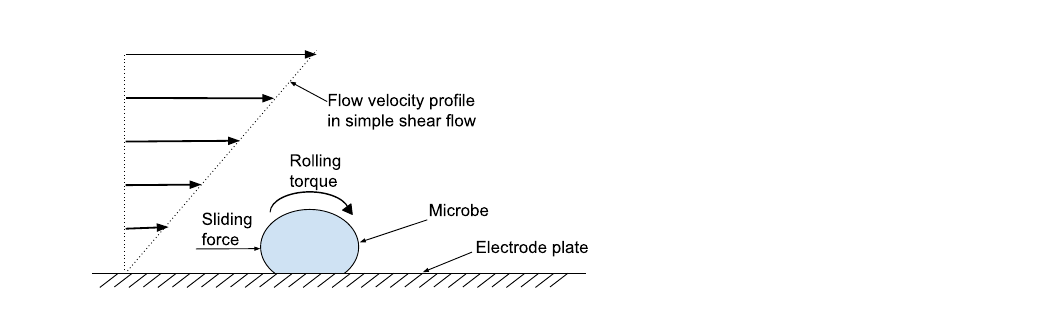
Figure 1. Microbe motion in electric field. A charged microbe deviates from the flow direction due to the electric field between electrode-plates. (created using Google Draw, https:// docs. google. com).